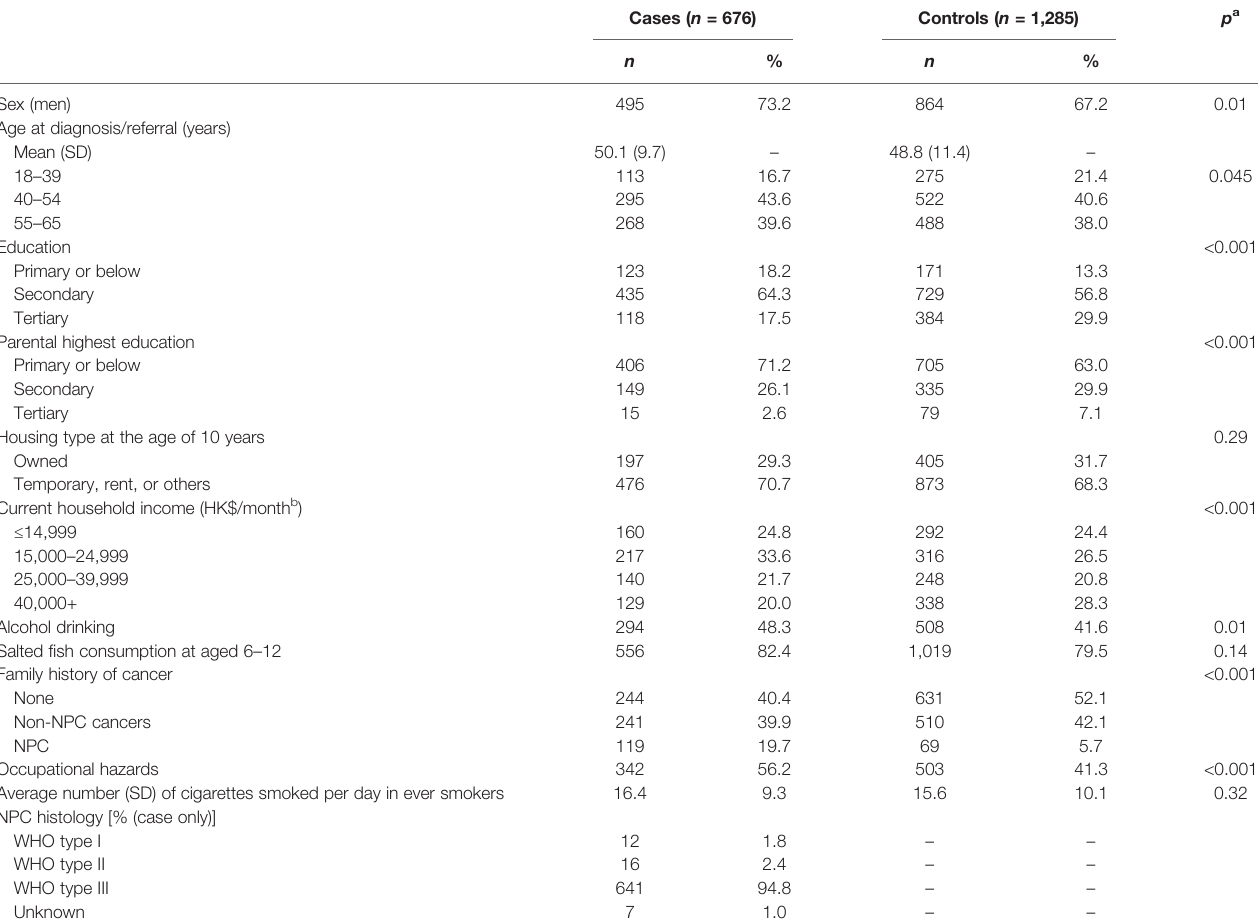
TABLE 1 | Characteristics of nasopharyngeal carcinoma cases and controls in subjects aged 18 –